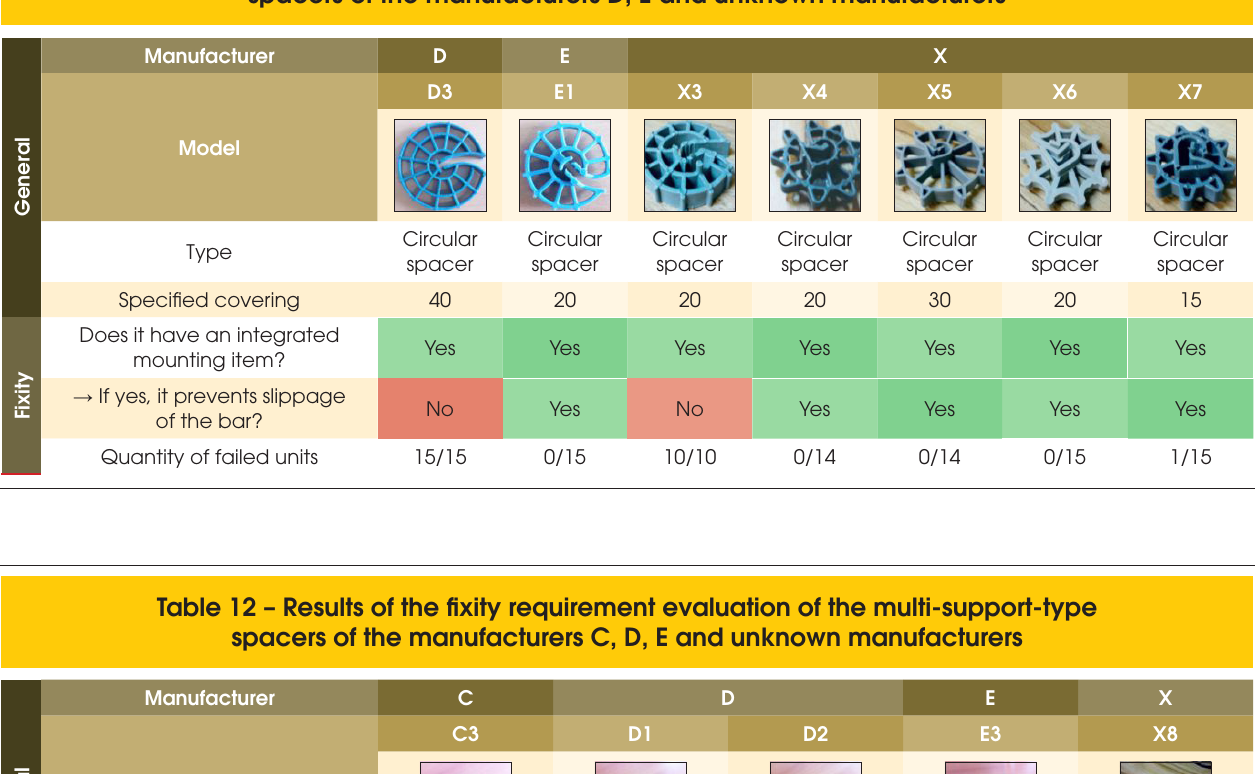
Table 11 – Results of the fixity requirement evaluation of the circular-type